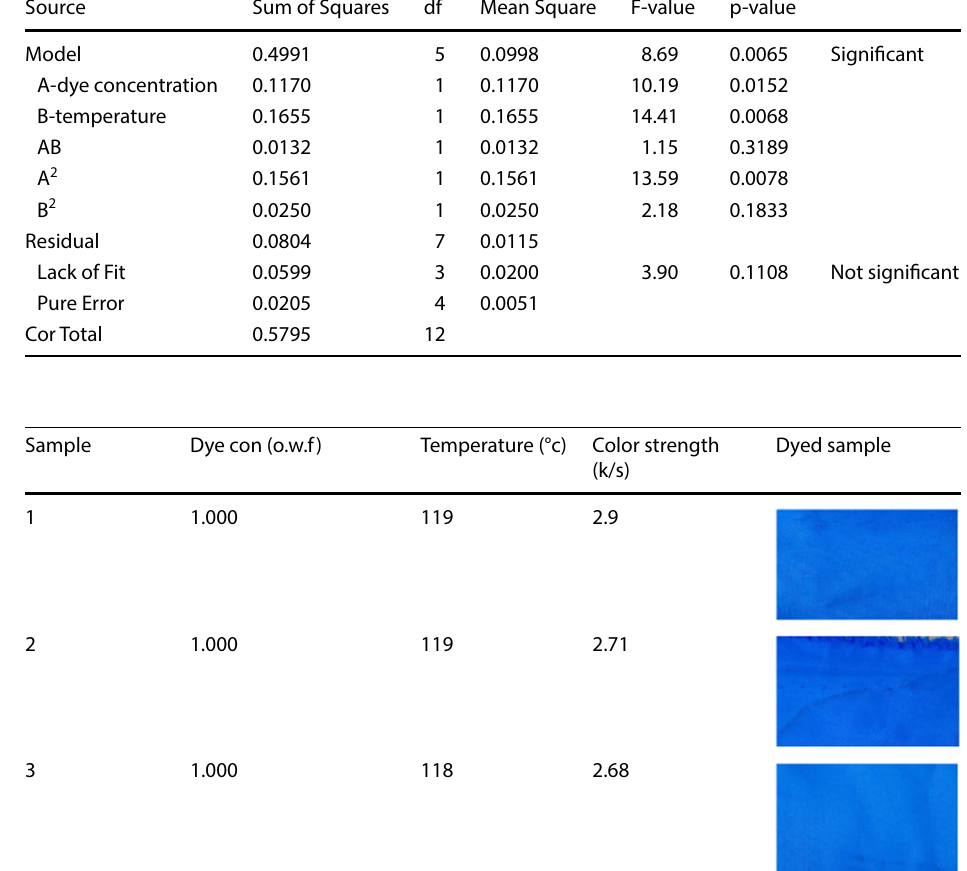
Table 4 ANOVA analysis of the esterification condition